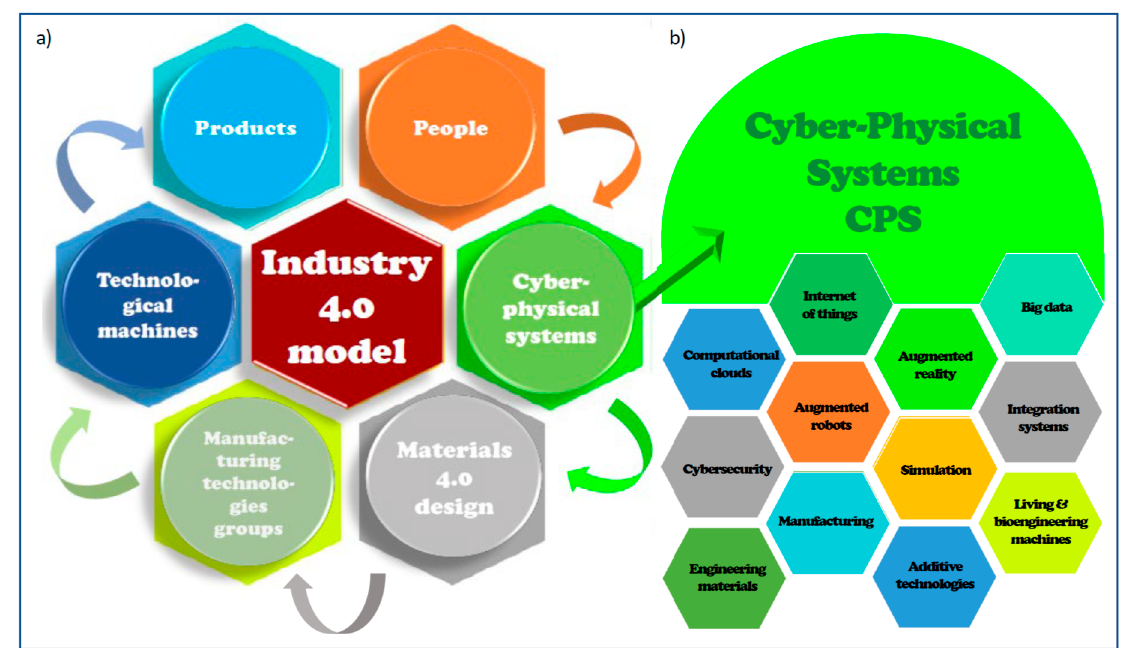
Figure 17. Examples of artificial organs, implants, and other medical devices to replace various tissues and organs of the human body and medical care.